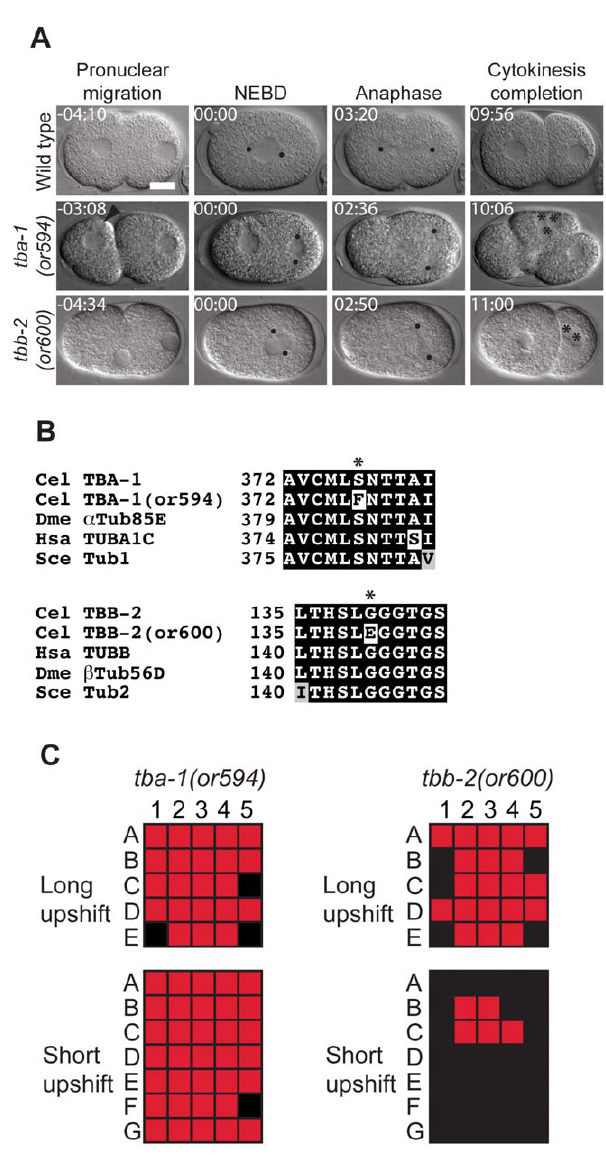
Figure 1. tba-1 and tbb-2 tubulin mutants. A. Differential interference contrast (DIC) time-lapse images of wild-type, tba- 1(or594 ts ), and tbb-2(or600 ts ) embryos. In the two tubulin mutants the P 0 spindle often is positioned transverse to the anterior posterior axis, and daughter cells contained multiple nuclei. The tba-1(or594 ts ) embryo was from a , 1 min. upshift and the tbb-2(or600 ts ) embryo was shifted to the restrictive temperature for 8 hours. Black dots represent centro- somes/spindle poles, asterisks denote multiple nuclei per cell, and the arrowhead indicates a second maternal pronucleus. Times in min:sec are given relative to nuclear envelope breakdown (NEBD). Scale bar, 10 m m. B. Amino acid alterations in the two mutants. Asterisks indicates the changed residues. Homologous proteins are aligned below the C. elegans protein. C. Defect maps for individual embryos observed during time- lapse recordings; embryos are listed on the left and phenotypes are listed on the top: 1; pronuclei meet prior to NEBD, 2; Nuclear centrosomal complex centration, 3; Nuclear centrosomal complex rotation, 4; spindle alignment, 5; one nucleus per cell at two cell stage. In the long upshifts, hermaphrodites were transferred to the restrictive temperature for 5– 8 hours. In the short upshifts, embryos were harvested from hermaph- rodites grown at 15 u C and immediately mounted on agar pads for imaging, which took about 1 minute. Red color indicates a defective trait, black color represents the lack of a